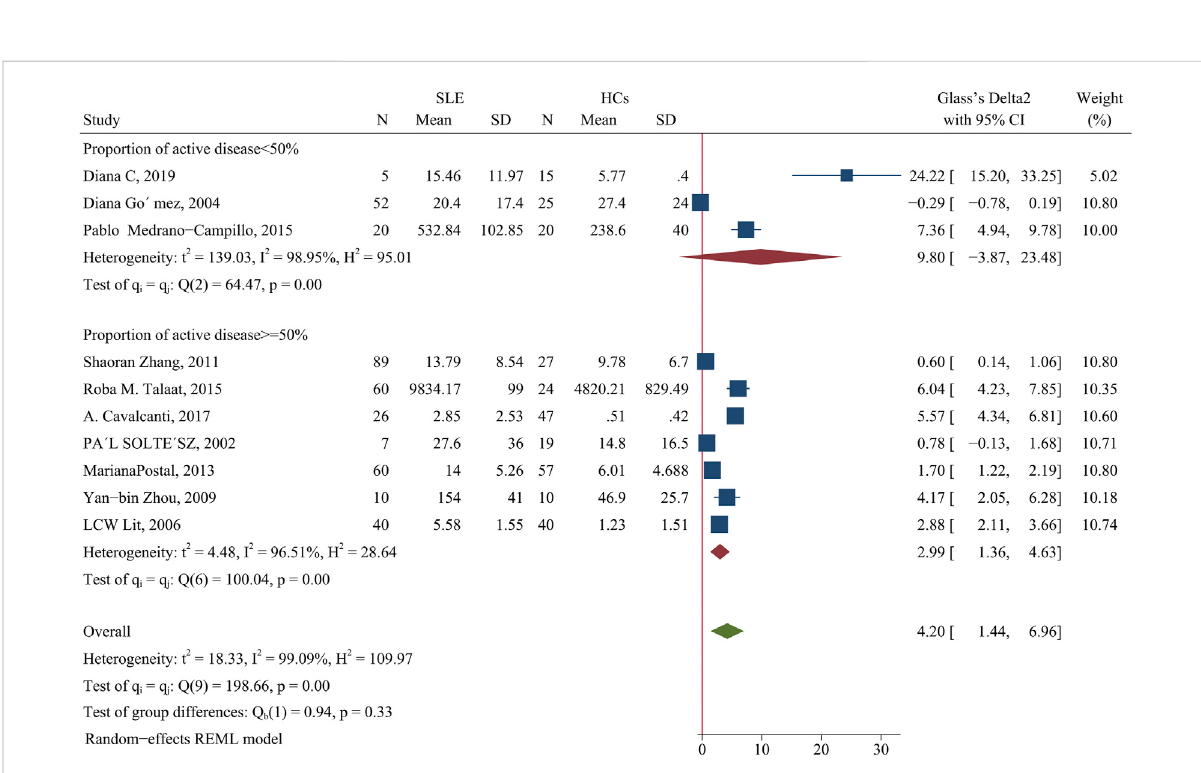
FIGURE 8 Forest plot of the concentration change of IL-10 in SLE patients compared with HCs. The overall results (bottom) show the meta-analysis of 10 studies, and the other two results show meta-analyses of subgroups according to the percentage of patients with active disease. SLE, systemic lupus erythematosus; HCs, healthy